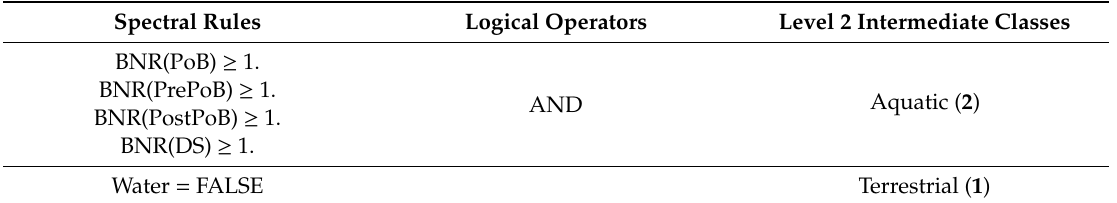
Table 6. Rules of the intermediate Level 2